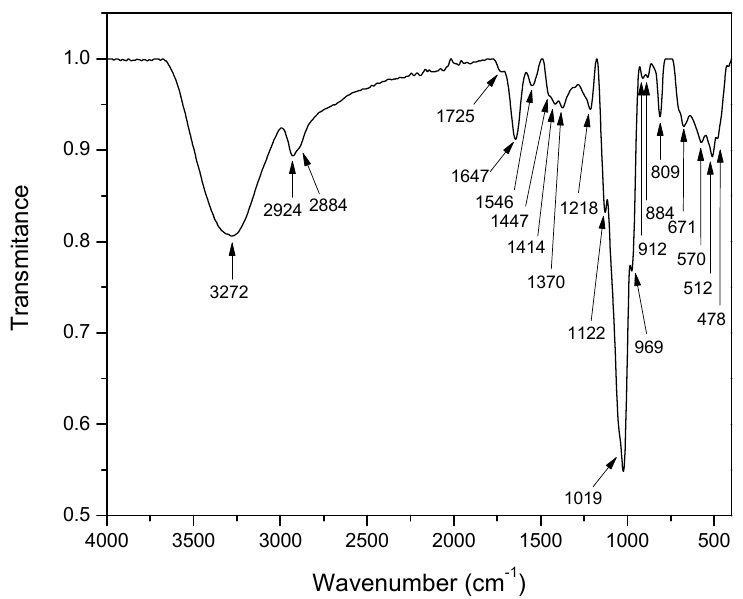
Figure 6. FTIR-ATR spectra of CamB6 isolated polysaccharide.